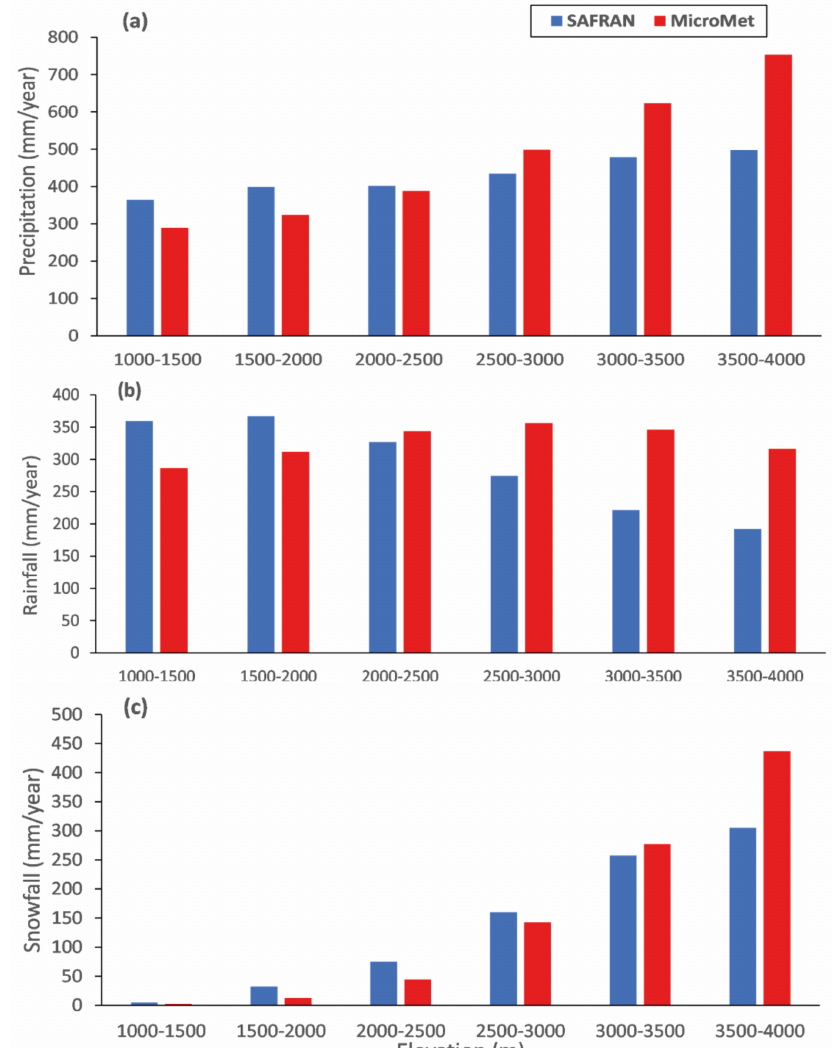
Figure 4. Average annual precipitation ( a ), rainfall ( b ) and snowfall ( c ) as a function of altitude for MicroMet and SAFRAN irregular grid on the Rheraya sub-basin, over the period